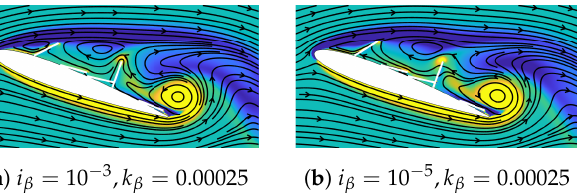
Figure 15. Vorticity contours at t / T = 0.45 demonstrating the upward moving flap 4 facilitating the upstream propagation of TEV induced reverse flow.